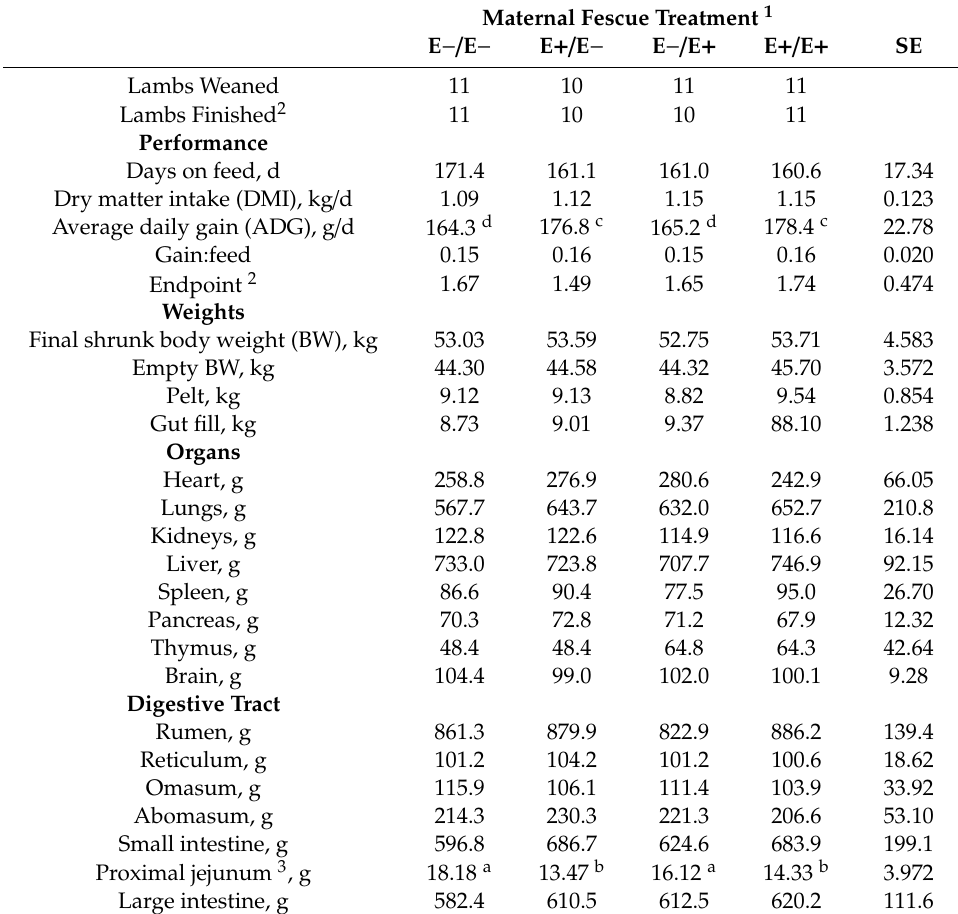
Table 2. Post-weaning growth rate, final weights, organ and digestive tract weight of wethers born to ewes consuming endophyte-infected (E + ) or endophyte-free (E − ) fescue during MID (d 35-85) and / or LATE (d 86-parturition)